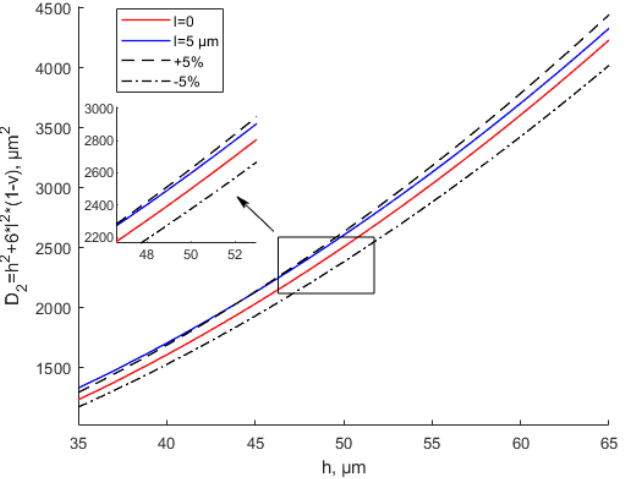
Figure 6. Modified couple stress and classical equivalent bending stiffness of thin plates shown with a small error when l = 5 μ m.